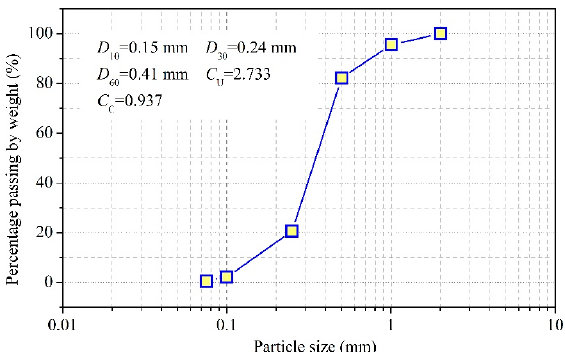
Figure 4. Grain size distribution of the soil used in the experiments. D 10 (or D 30 and D 60 ) means